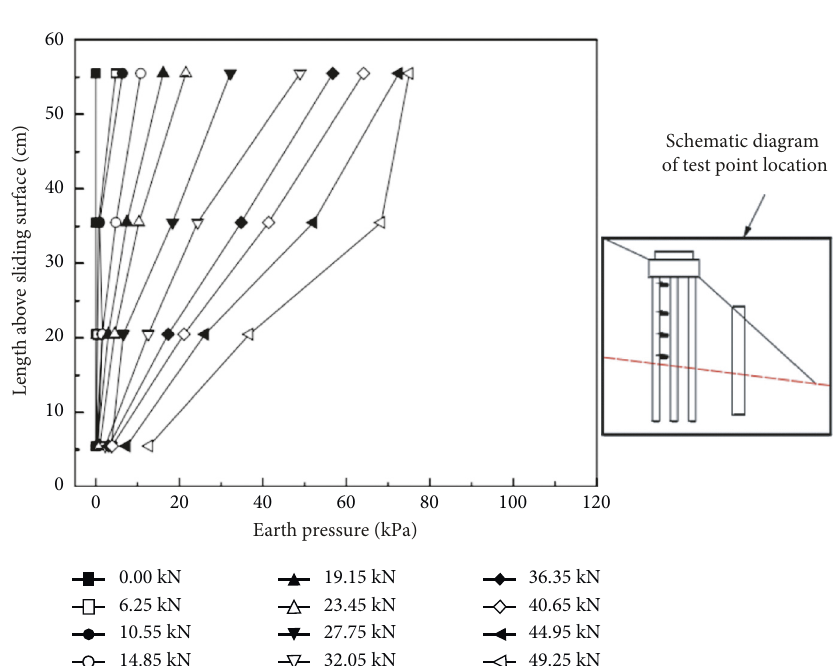
Figure 20: Relationship between soil pressure distribution and load among piles in bridge